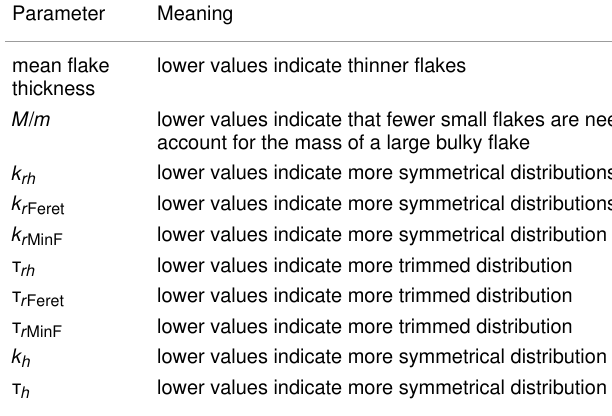
Table 3: Summary of the analysis for all four samples. Parameter